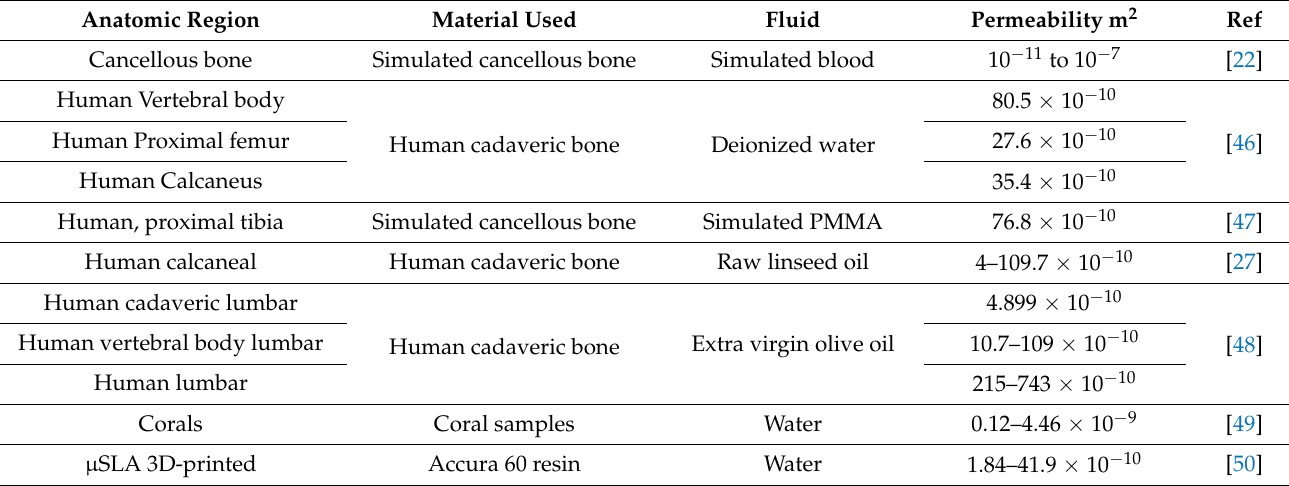
Table 8. Comparison between intrinsic permeability values of natural human bone and synthetic porous scaffold